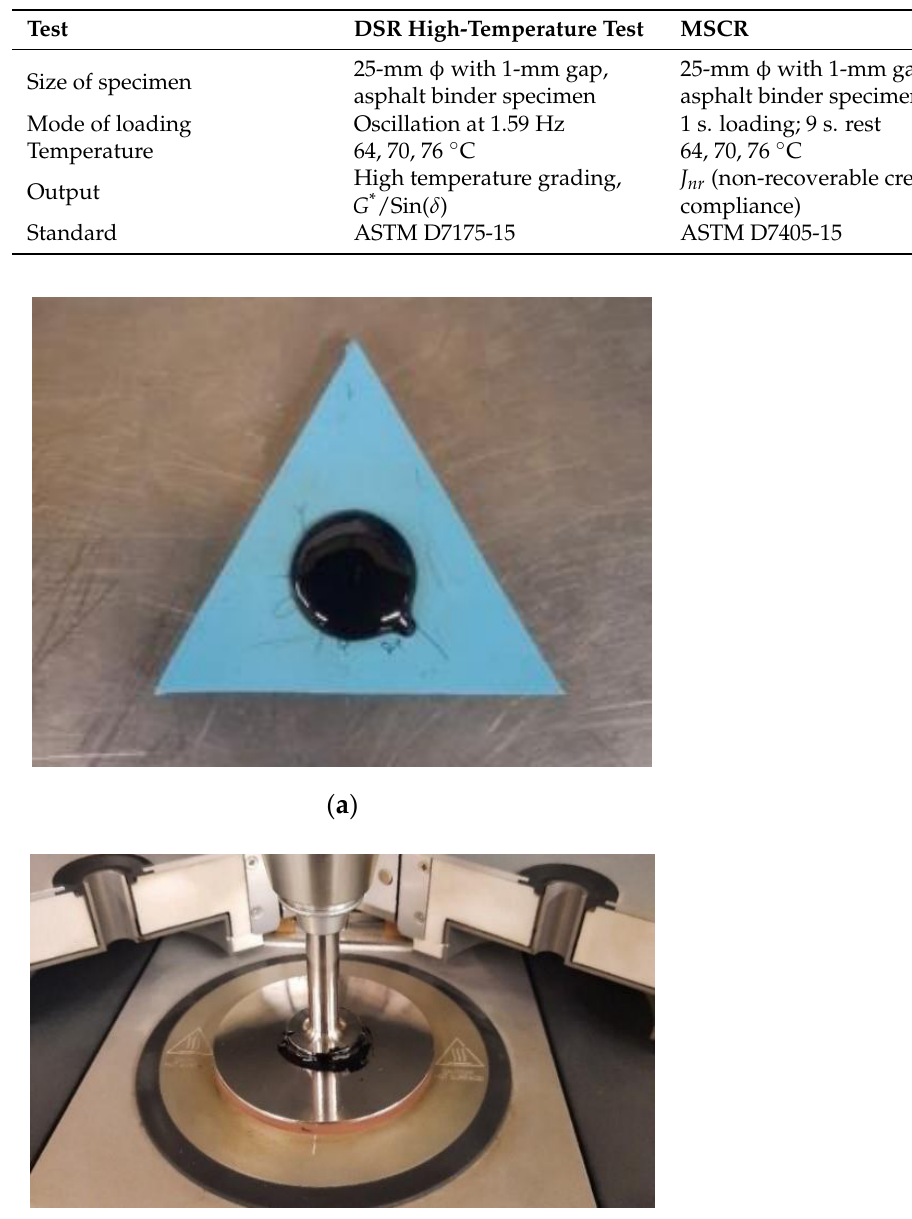
Table 2. Test description and specifications.